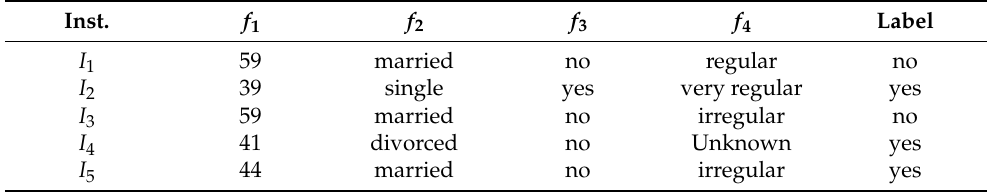
Table 2. Example of the initial dataset.